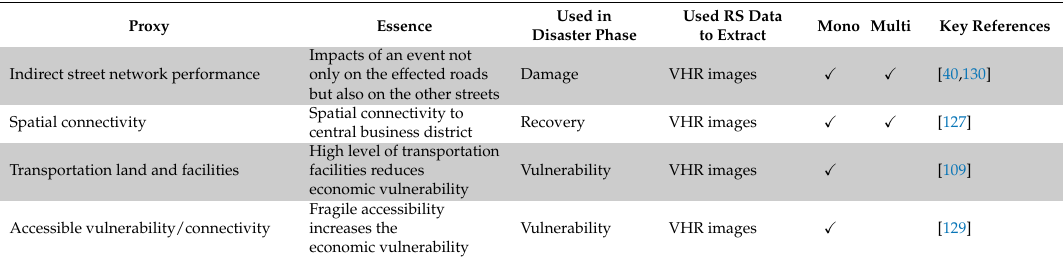
Table 5. Remote sensing-based economic proxies for urban DRM, Logistics category. Mono and Multi refer to mono-temporal and multi-temporal RS data that used for extraction,